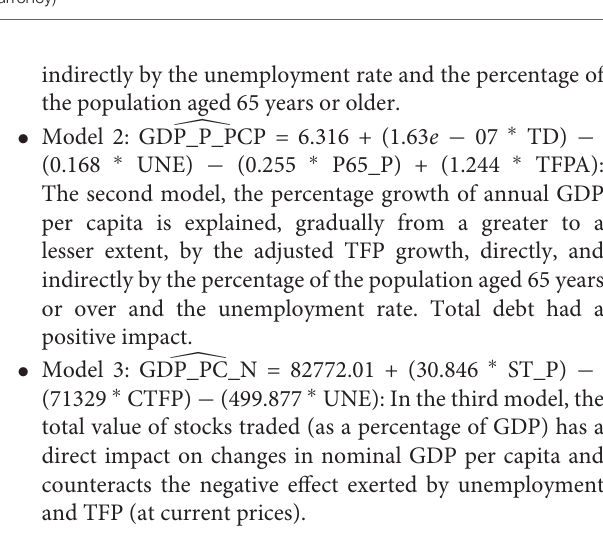
Penn World Table, version 9.0 a